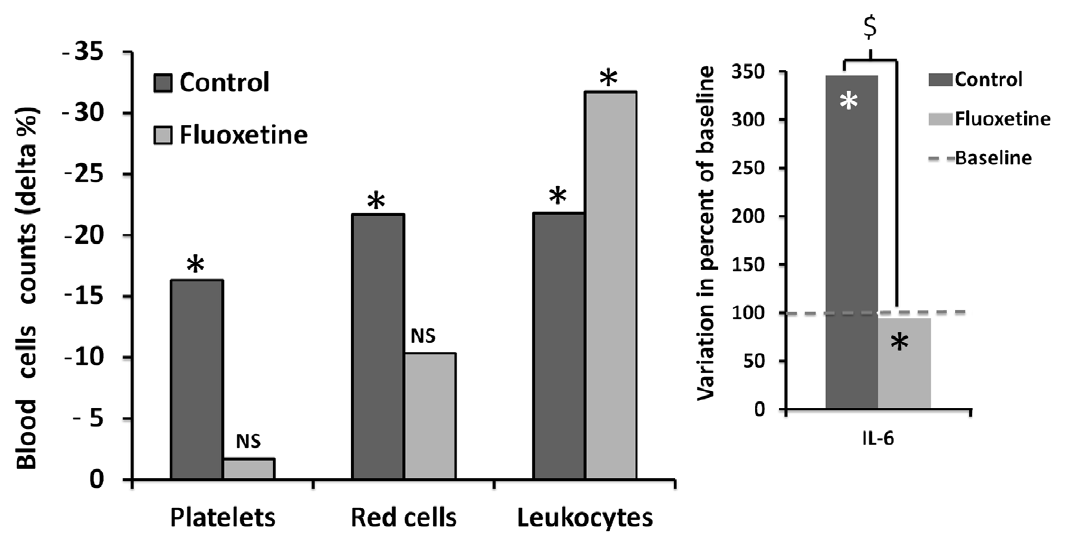
Figure 4. Percents of blood cells consumption after decompression from the baseline in dark grey for the mice treated with fluoxetine and light grey for the controls. *denotes a significant difference between pre- and post-decompression. On the right, changes (%) in circulating cytokine IL-6 levels after decompression from the baseline. $ denotes a significant difference between groups. *denotes p , 0.05 from the